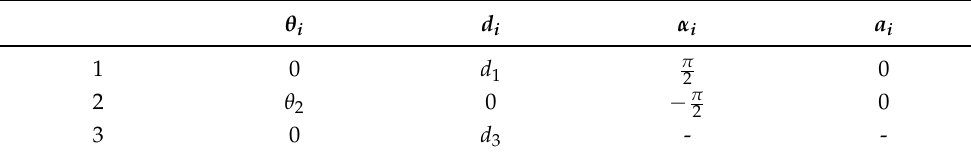
Figure 5. PRP kinematic chain. Table 1. DH parameters of a PRP